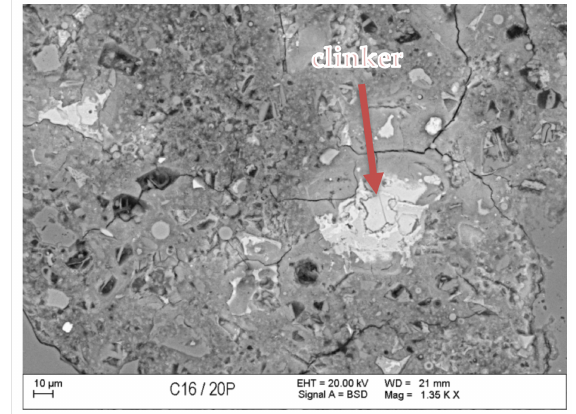
Figure 12. BSE image of FA concrete